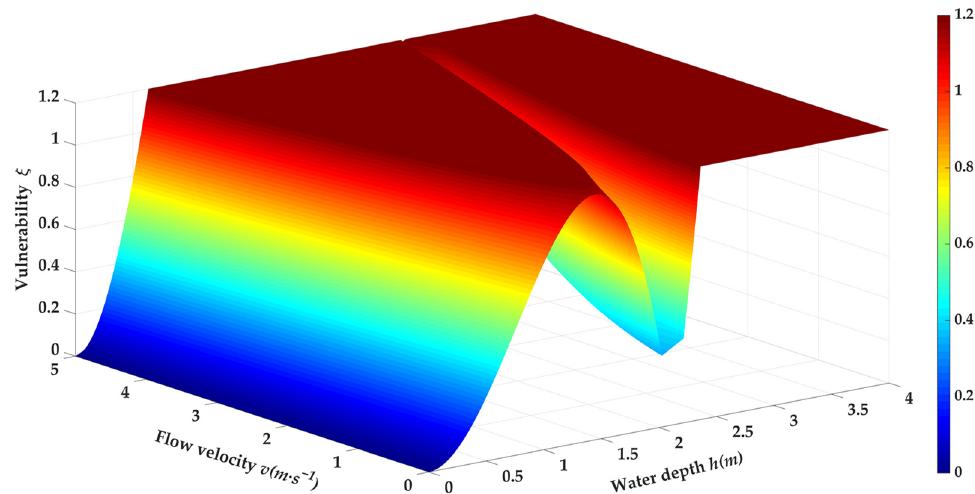
Figure 4. Vulnerability curve of masonry buildings.